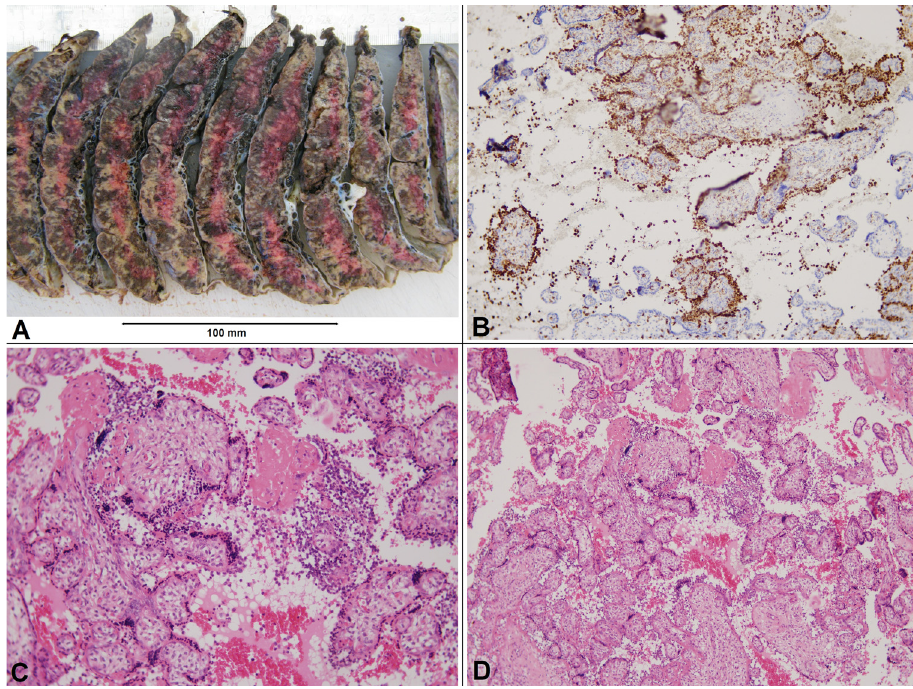
Fig. 2. Histopathological assessment of